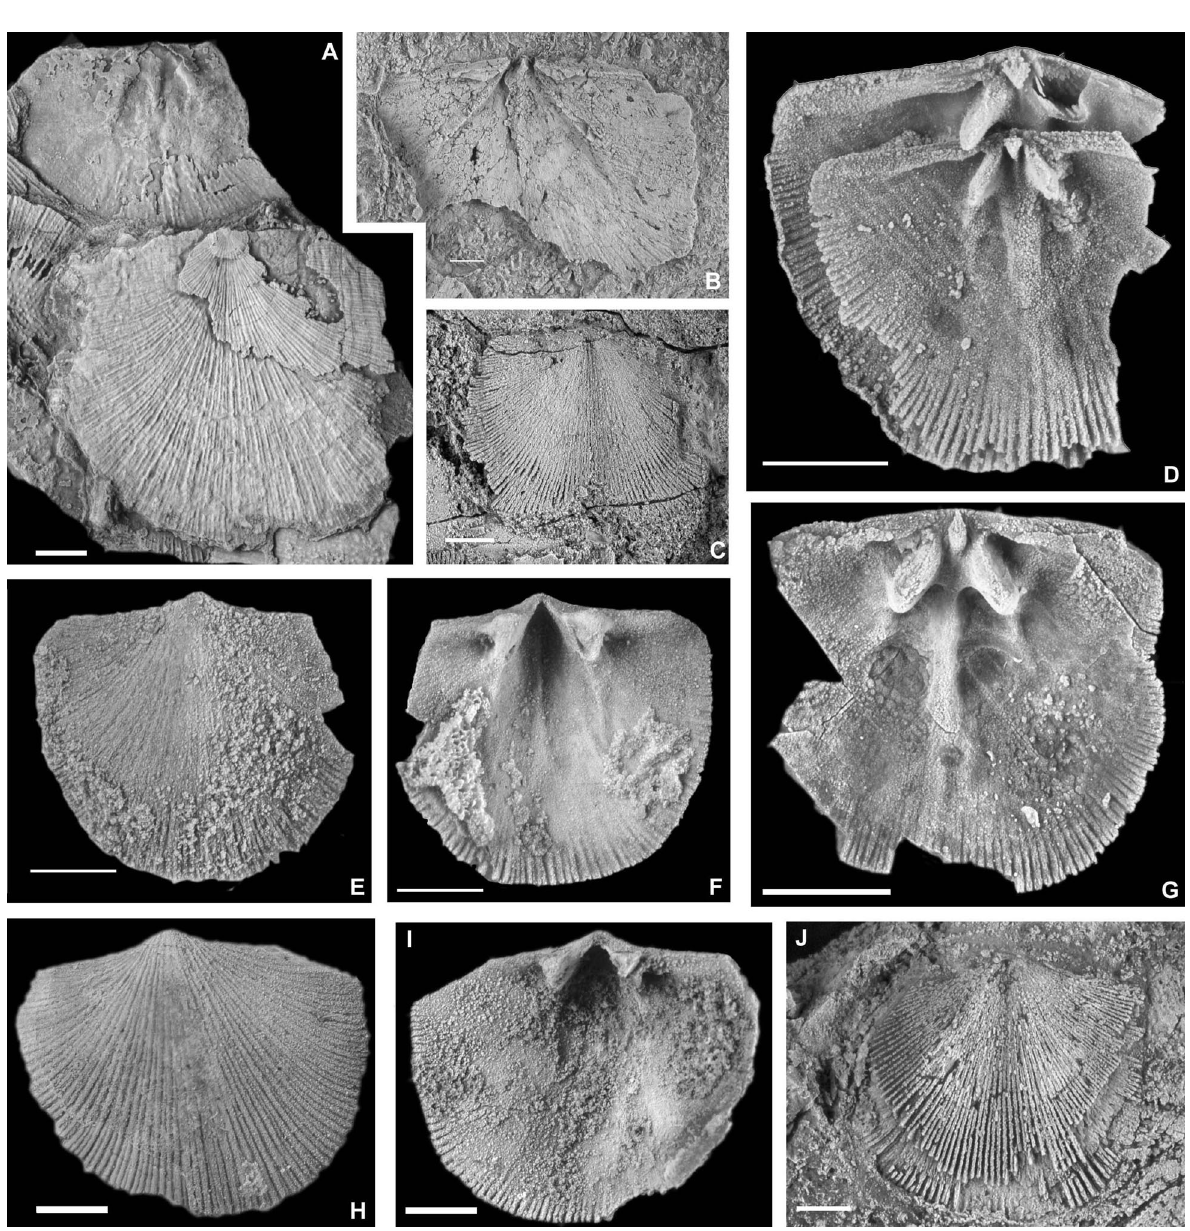
dorsal valve interior and NMW 2011.11G.8, 9, dorsal valve exterior, sample K25, Boghu Mountains; B, NMW 2011.11G.6, ventral valve interior, sample S14, Derenjal Mountains. C(cid:150)J , Isorthis ( Ovalella ) inflata sp. nov. Llandovery, mid-late Aeronian, Niur Formation; sample S14, Derenjal Mountains; C, NMW 2011.11G.114.6, dorsal valve exterior; D, NMW 2011.11G.191, 192, dorsal valve interiors; E, F, NMW 2011.11G.15, ventral valve exterior, interior; G, NMW 2011.11G.190, dorsal valve interior; H, I, NMW 2011.11G.14, ventral valve exterior, interior; J, NMW 2011.11G.115, dorsal valve exterior. All scale bars 2